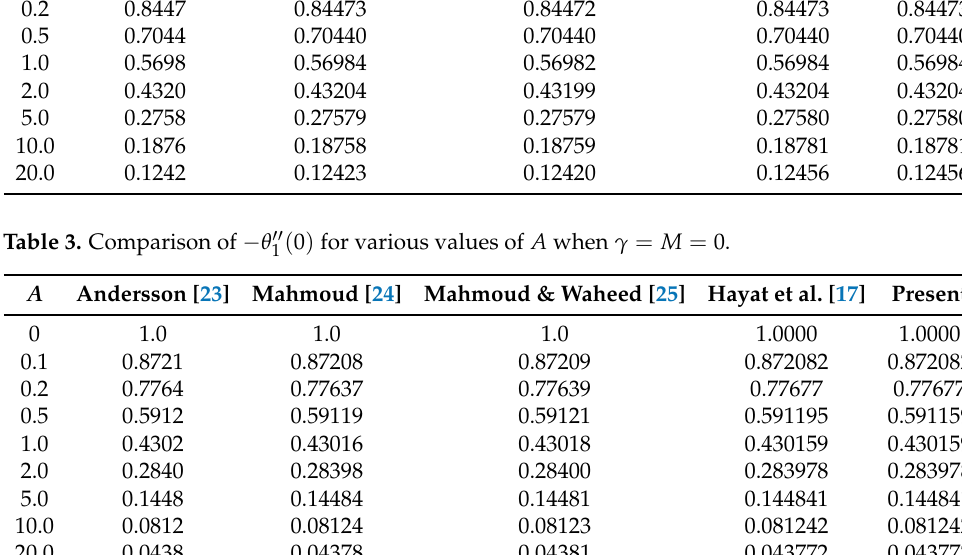
Table 2. Comparison of θ (cid:48) A